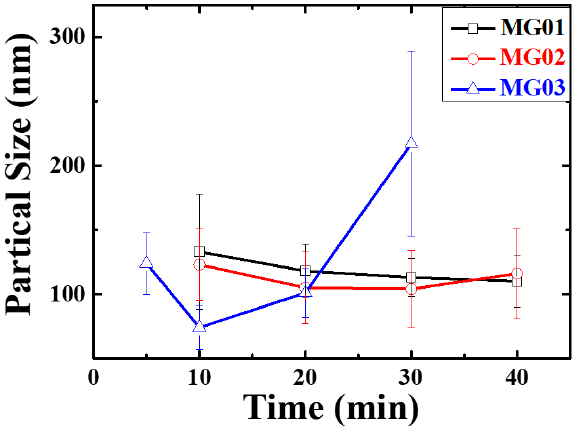
Figure 4. PVDF phase domain size as a function of mixing time and compatibilizers.